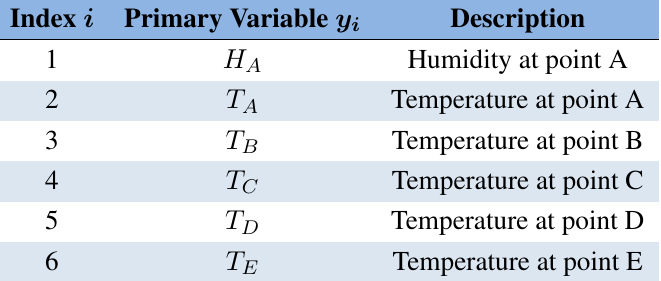
Table 2. Primary variables of the neonatal